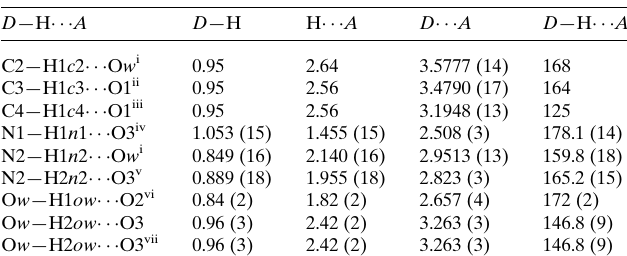
Table 1 Hydrogen-bond geometry (A˚ , (cid:5) ).